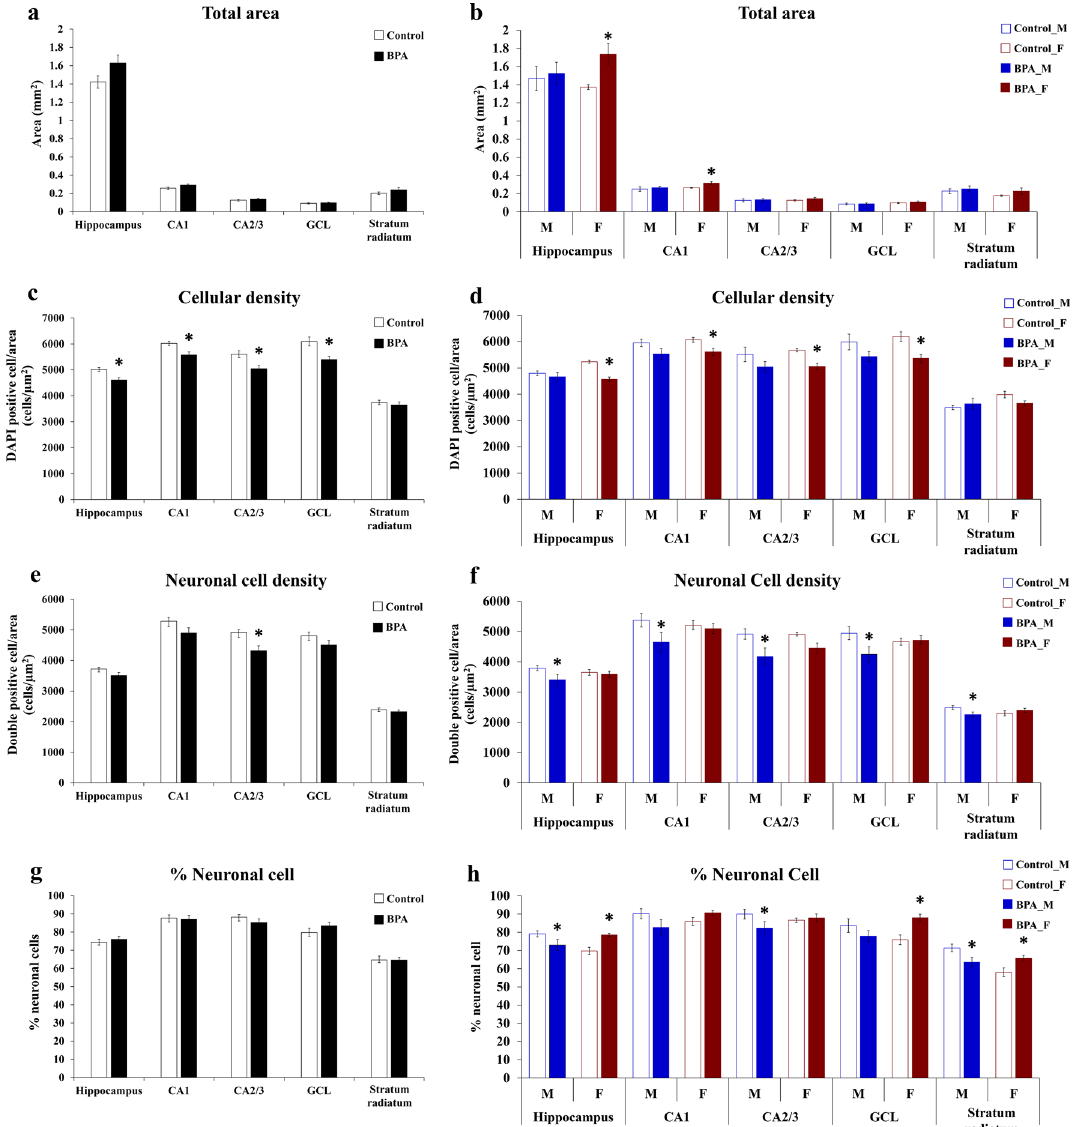
Figure 4. Quantification of the total area, the number of NeuN-positive cells, and the number of NeuN/ DAPI double-positive cells in the hippocampus, CA1, CA2/3, DG, and stratum radiatum of the rat offspring prenatally exposed to BPA compared to those in the control group. The total area ( a , b ), cellular density ( c , d ), neuronal cell density ( e , f ), and percentage of neuronal cells ( g , h ) in the hippocampus, CA1, CA2/3, DG, and stratum radiatum were determined in the BPA group and compared with those in the vehicle control group. Hippocampus tissues (both sides) from three male and three female offspring were used in each treatment group. Data are presented as the mean ± SEM. * P value < 0.05. *Indicates a statistically significant difference between the BPA treatment and the vehicle control